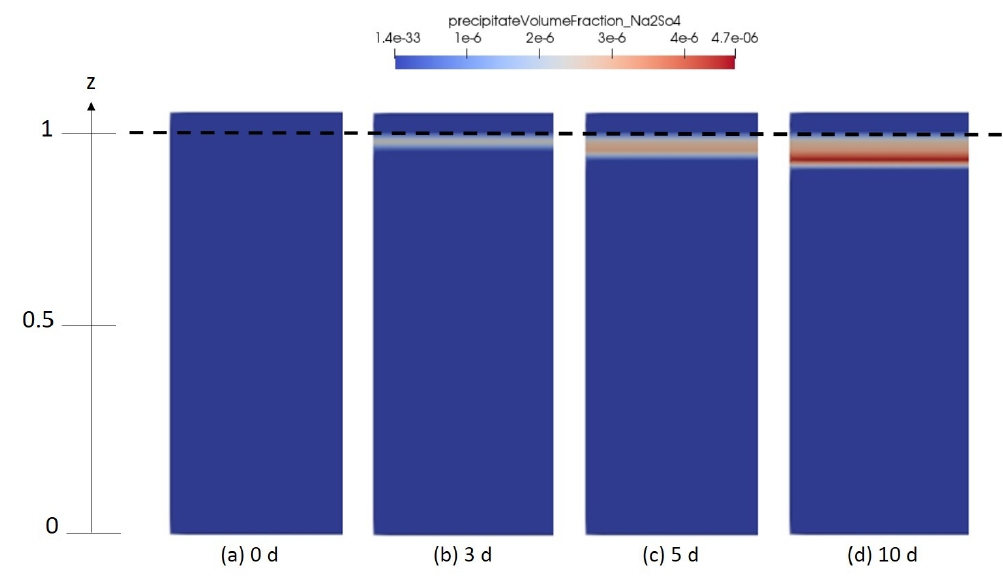
Figure 11. Numerical results depicting the spatial distribution of thenardite solidity in the porous medium domain for different time intervals ( a ) 0 days, ( b ) 3 days, ( c ) 5 days and ( d ) 10